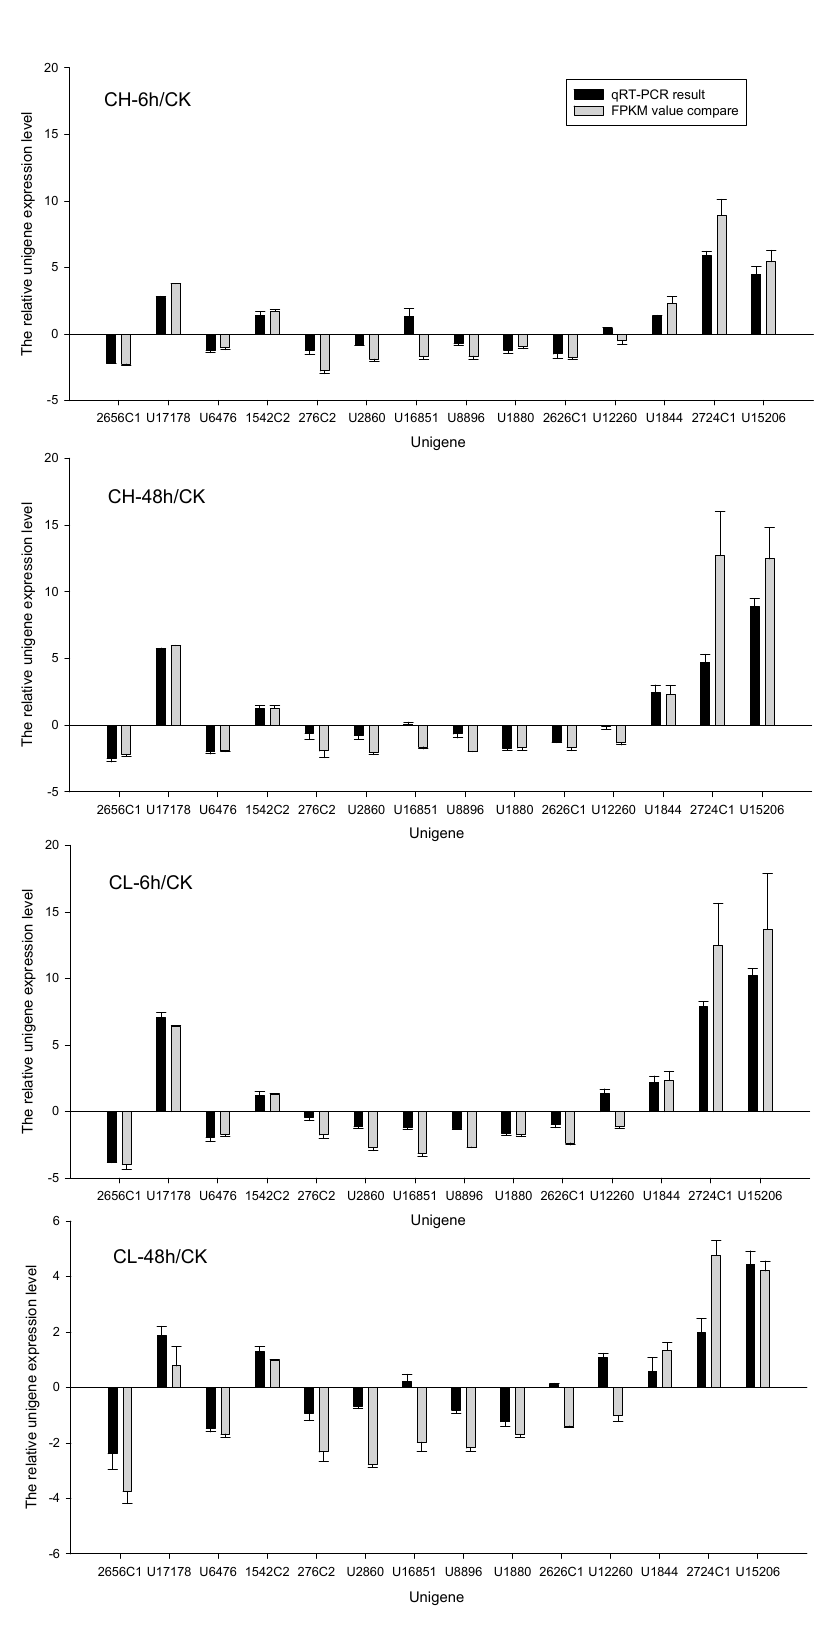
Figure 6. Insecticide-metabolism-related unigenes in comparison with control as confirmed by Quantitative Real-Time Polymerase Chain Reaction (qRT-PCR) and the calculated fragments per kilobase of transcript per million mapped reads (FPKM) values. CK: Control; CH: Chlorpyrifos; CL: Clothianidin; 6 h: treated 6 h; 48 h: treated 48 h. In the relative gene expression level (log2R) on Y-axis, R indicates the ratio of unigene expression in insecticides treated as compared with that in control.